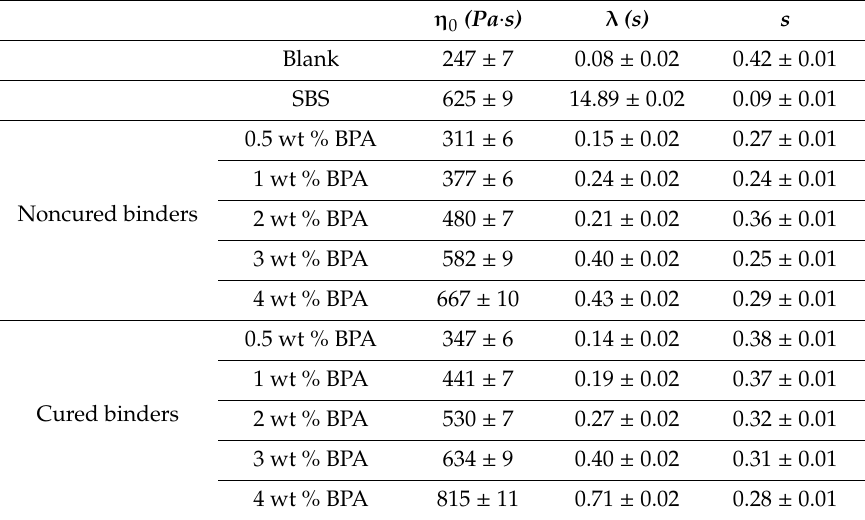
Table 1. Carreau model parameters for the studied